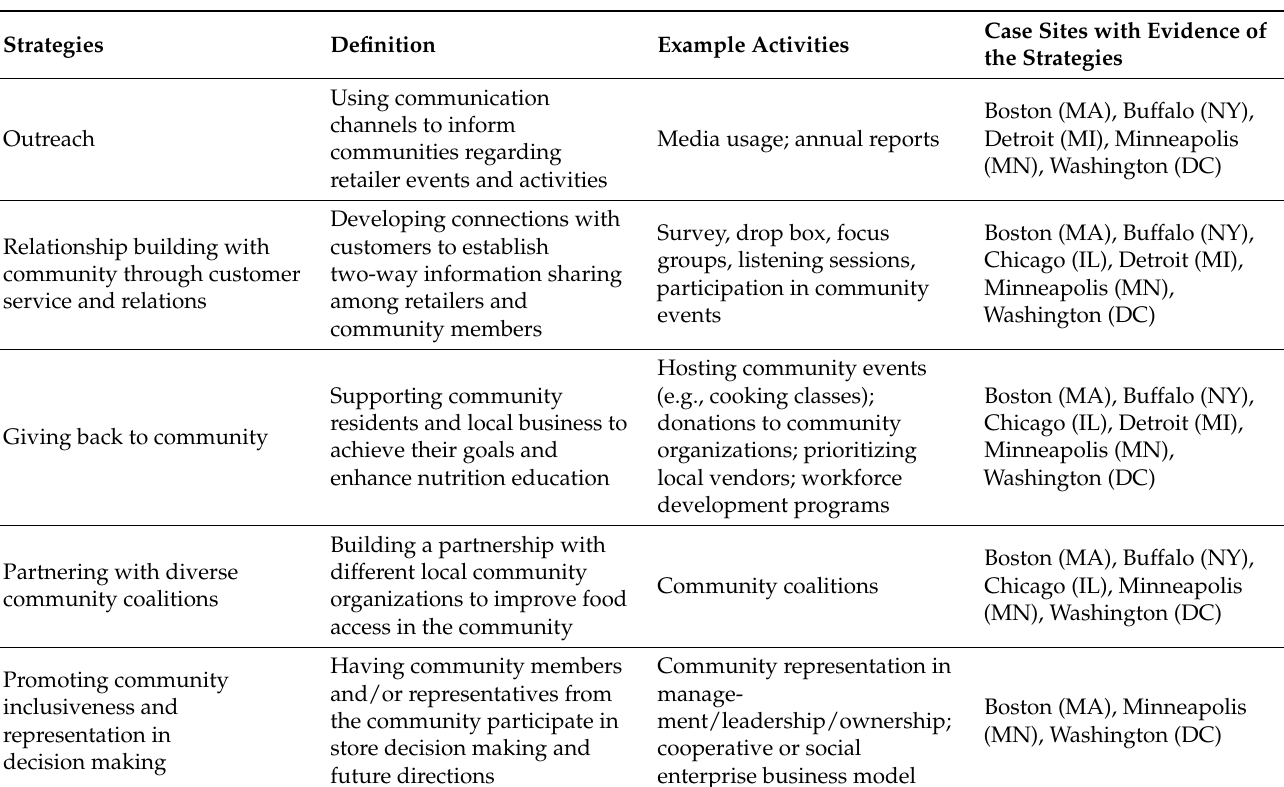
Table 2. Community engagement strategies, associated activities, and case sites that demonstrated a use of the